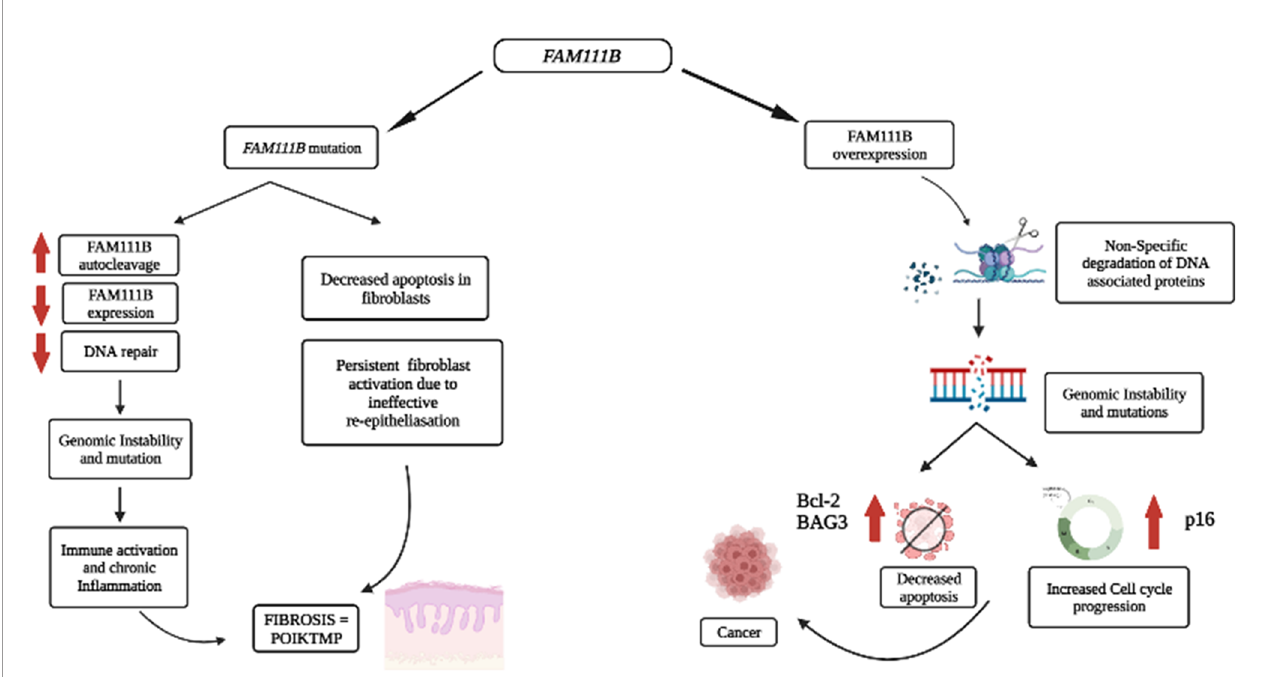
FIGURE 2 | Proposed pathological processes involving FAM111B in cancer and POIKTMP. An increase in FAM111B expression possibly leads to an increase in proteolysis of DPCs and non-speci fi c degradation of chromatin-associated proteins, which leads to genomic instability. Genomic instability is a signi fi cant characteristic of cancer. A decrease in FAM111B possibly leads to the reduction in apoptosis of fi broblasts, which causes an increase in fi brosis (Created with